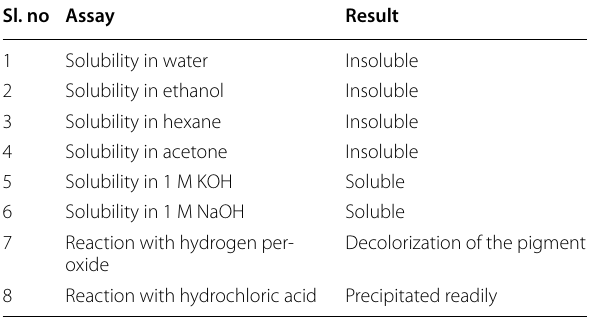
Table 3 Biochemical characterization of melanin Sl. no